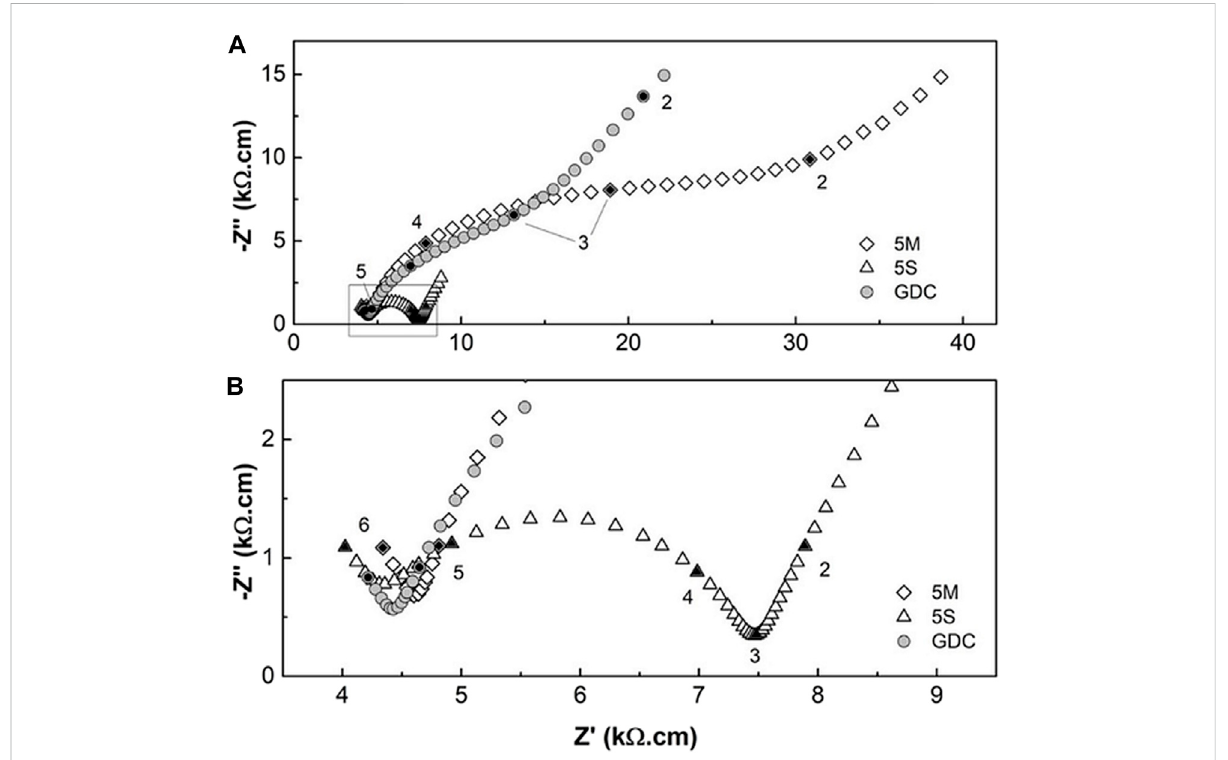
FIGURE 4 (A) Impedance spectra of GDC materials without and with NLC as sintering aid; (B) zoomed area from (A) . Numbers close to data points correspond to the log 10 of the frequency (Hz). Adapted from (Grilo et al., 2020). See text for